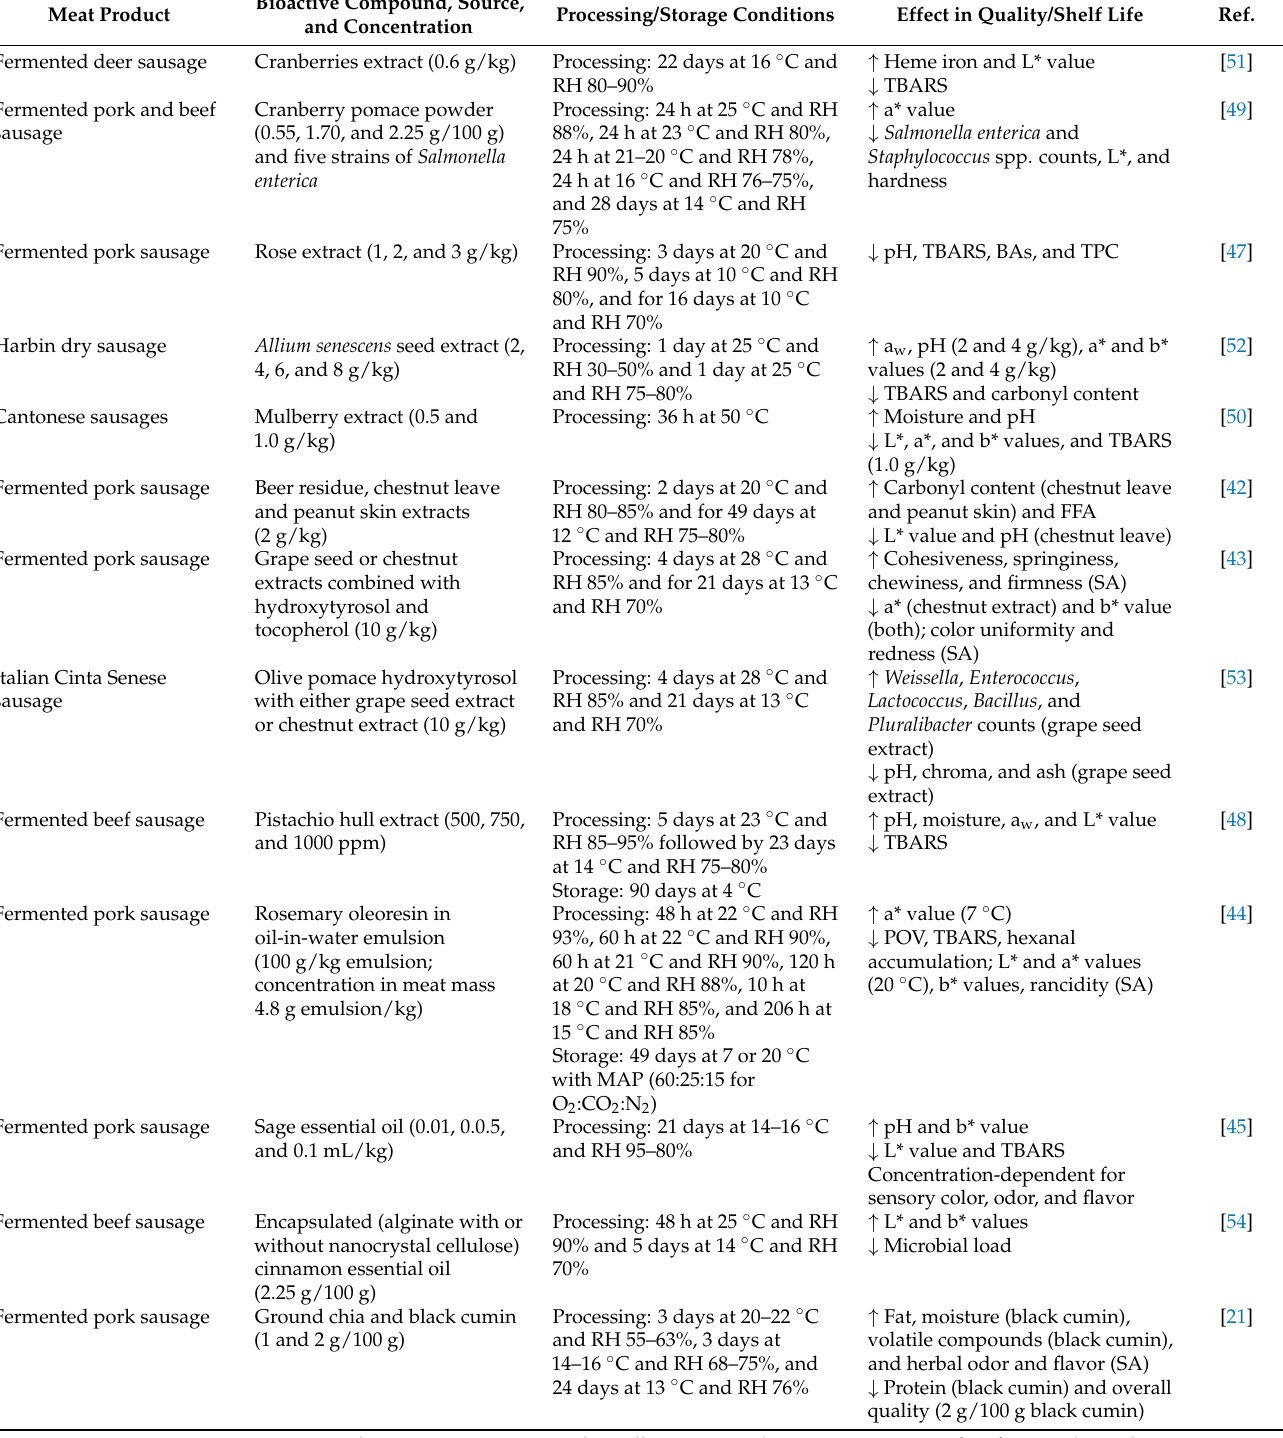
Table 1. Main bioactive compounds from plant origin used in fermented meat